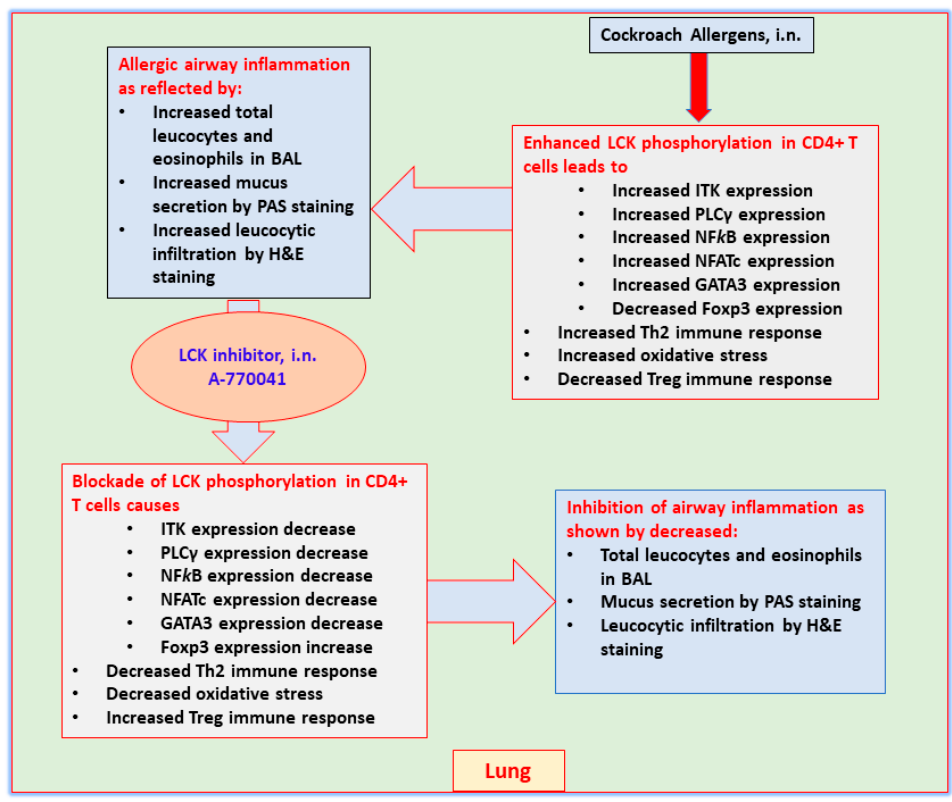
Figure 8. Presumptive mechanism of action of LCK inhibitor, A-770041 on airway inflammation in CE-induced mouse model of asthma based on the observations of this study.